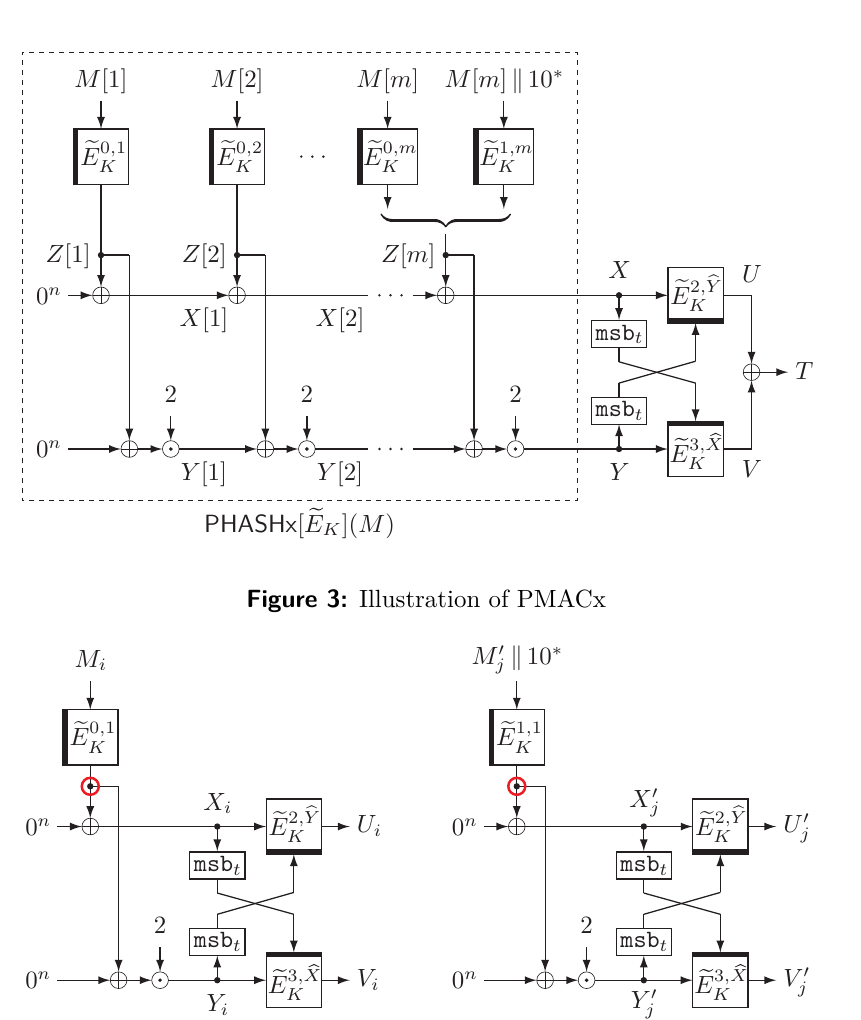
Figure 4: Our attack against PMAC2x. The left figure illustrates Step 1 and the right one illustrates Step 2. We see that the collision between the two red circles implies both X i = X 0 and Y i = Y 0 j j